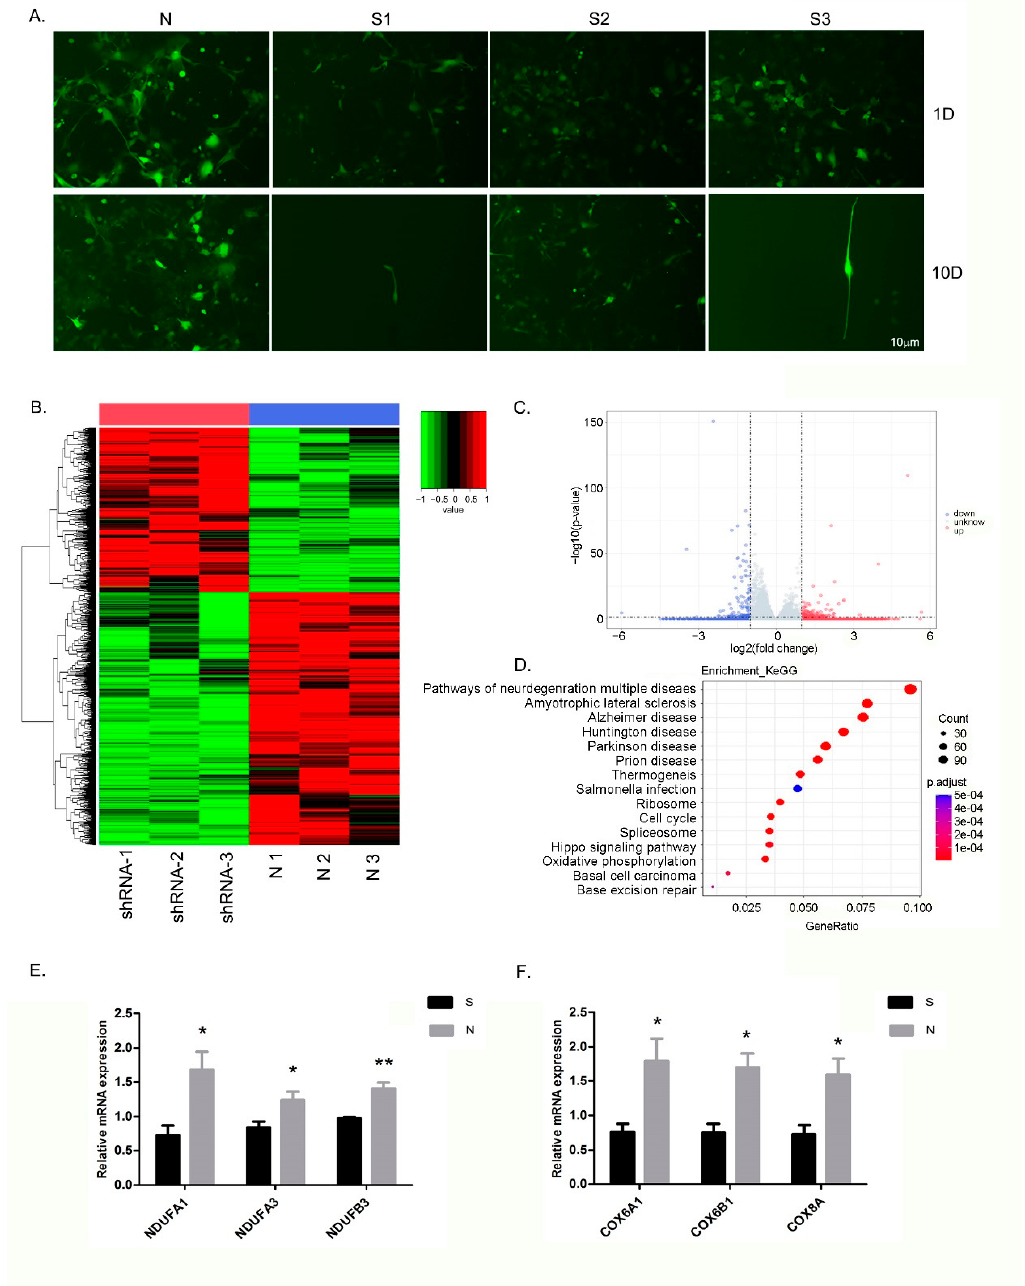
Figure 4. Effect of ZC4H2 knockdown on the NSCs. ( A ) Growth of NSCs infected with lentiviral vectors at different points. N: the NSCs infected with the normal control lentiviruses (with a GFP reporter gene); S1–S3: the NSCs infected with three different shRNA-containing lentiviruses targeting the ZC4H2 gene, respectively. The NSCs images were taken using a fluorescence microscope on day 1 and day 10 of selection using Puromycin. ( B ) Heatmap of RNA-seq. The NSCs infected with the shRNA-lentivirus targeting ZC4H2 and normal controls, respectively. The experiments were repeated three times for each group. ( C ) Volcano plot of RNA-seq. A total of 4091 DEGs were obtained and 1608 genes were shown to be up-regulated and 2483 genes were down-regulated in the S group. ( D ) KEGG pathway analysis of the up-regulated genes. The top 15 significant KEGG pathways were shown. ( E , F ) RT-qPCR analysis for DEGs related to oxidative phosphorylation complex. * indicated significant differences compared with the control group ( p < 0.05). ** indicates highly significant differences compared with the control group ( p < 0.01).